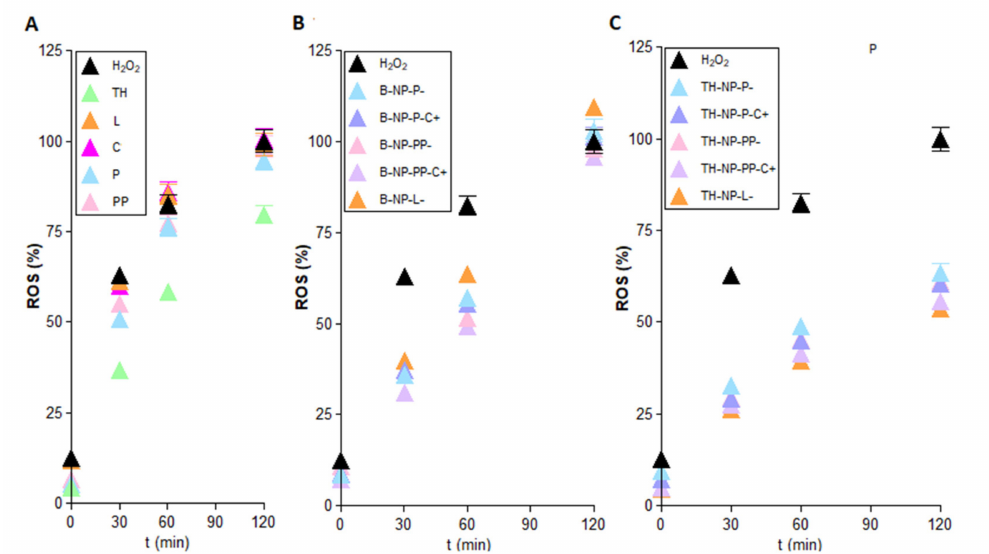
Figure 10. Antioxidant activity of ( A ) TH and free surface compounds, ( B ) B-NPs (blank NPs) and ( C ) TH-NPs evaluated in HaCaT cells challenged with H 2 O 2 . ROS were quantified using the fluorescent probe H2DCFDA. Data are expressed as the Mean ± SD ( n = 8) of the amount of quantified ROS (%), assigning the value of 100 to the amount of ROS generated after 120 min treatment with H 2 O 2